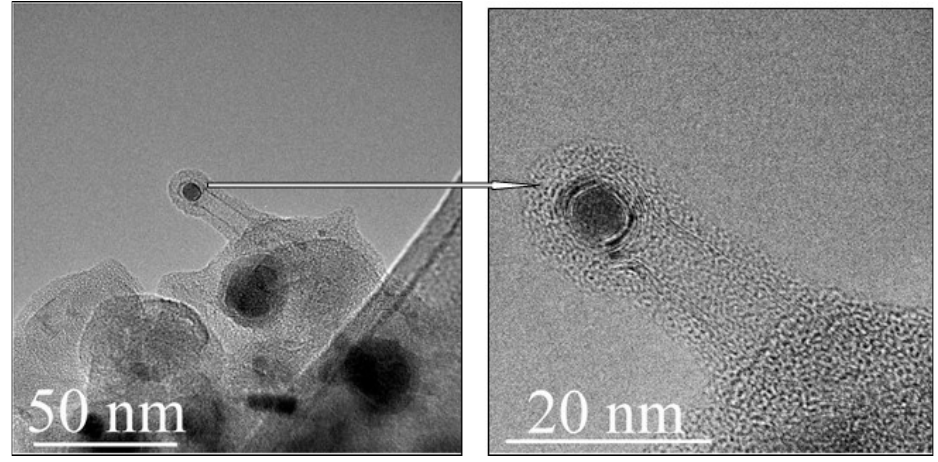
Figure 3. TEM images of a short single CNT as a co ‐ product obtained in the turbulence zone of the CNT ‐ cotton synthesis reactor .